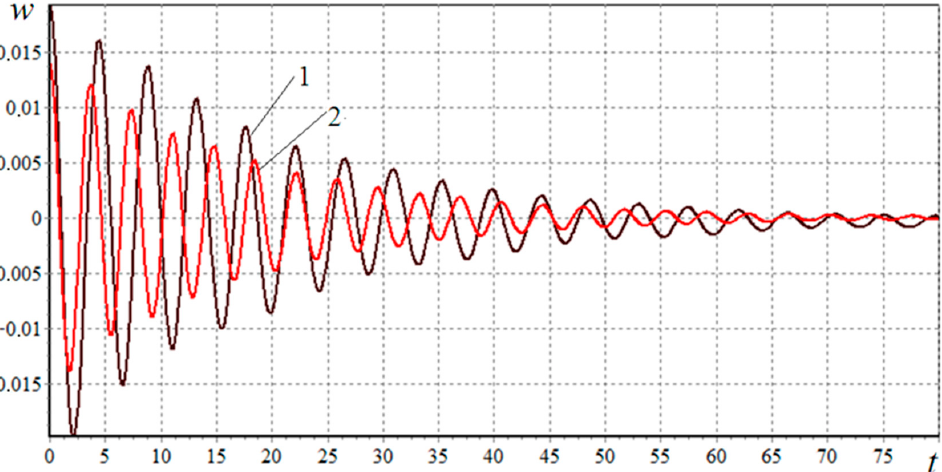
Figure 8. Dependence of the deflection on time for various boundary conditions: (1) two opposite sides are simply supported, and the other two are с lamped; (2) all sides are с lamped.